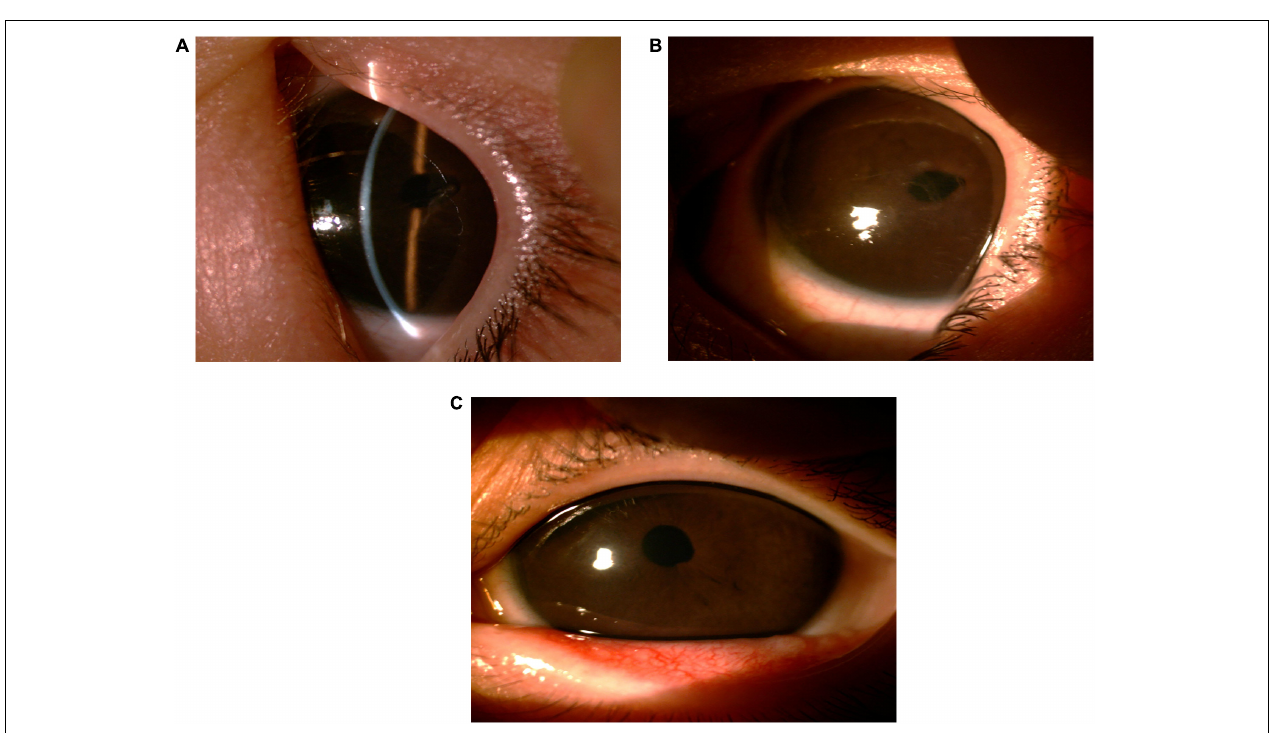
FIGURE 3 | Slit lamp examination of the left eye in routine follow-ups. (A,B) Captured 2 months after surgery. (C) Captured 14 months after surgery.